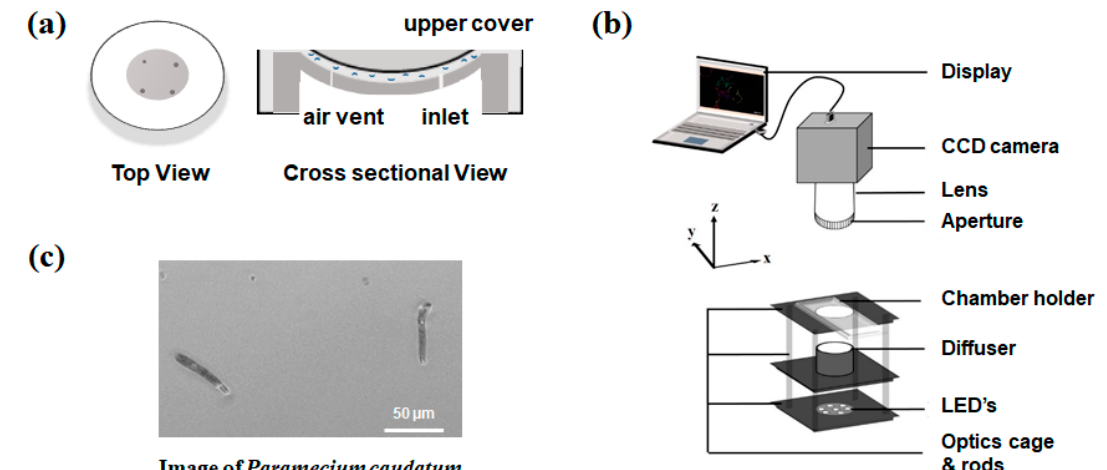
Figure 1. ( a ) Curved microfluidic chamber with a diameter of 12 mm; ( b ) A charge-coupled device